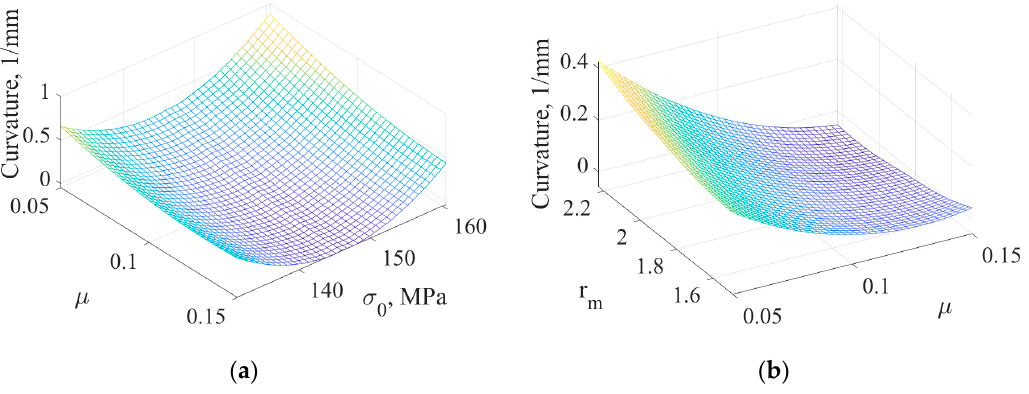
Figure 13. Metamodel of curvature for a fluctuation in ( a ) µ and σ 0 and ( b ) µ and r m .